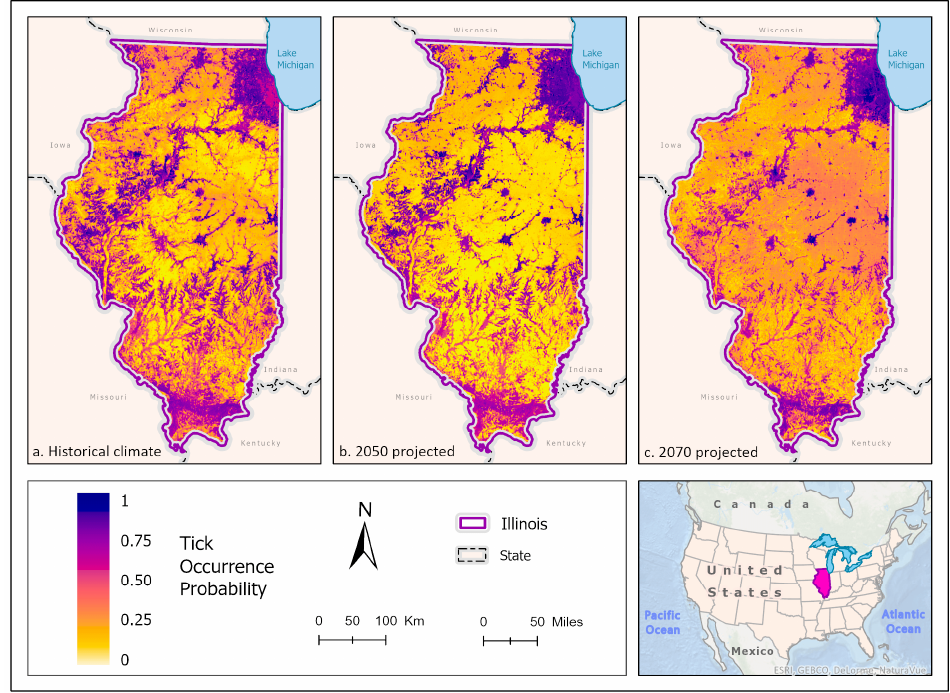
Figure 8. ( a ) Mean-weighted ensemble prediction of the probability of A. maculatum occurrence in Illinois under historical climate conditions. ( b ) Mean-weighted ensemble of predicted probability of A. maculatum occurrence in Illinois in 2050 projected climate Coupled Model Intercomparison Pro- ject phase 6 (CMIP6)/EC-Earth3-Veg Shared Socioeconomic Pathway (SSP) 585 (average from 2041 to 2060). ( c ) Mean-weighted ensemble of future predicted probability of A. maculatum occurrence in Illinois in 2070 projected climate (CMIP6)/EC-Earth3-Veg Shared Socioeconomic Pathway (SSP) 585 (average from 2061 to 2080). Darker colors indicate a higher likelihood of tick presence per the tick occurrence probability scale. Inset map indicates the location of Illinois within the United States/North America.